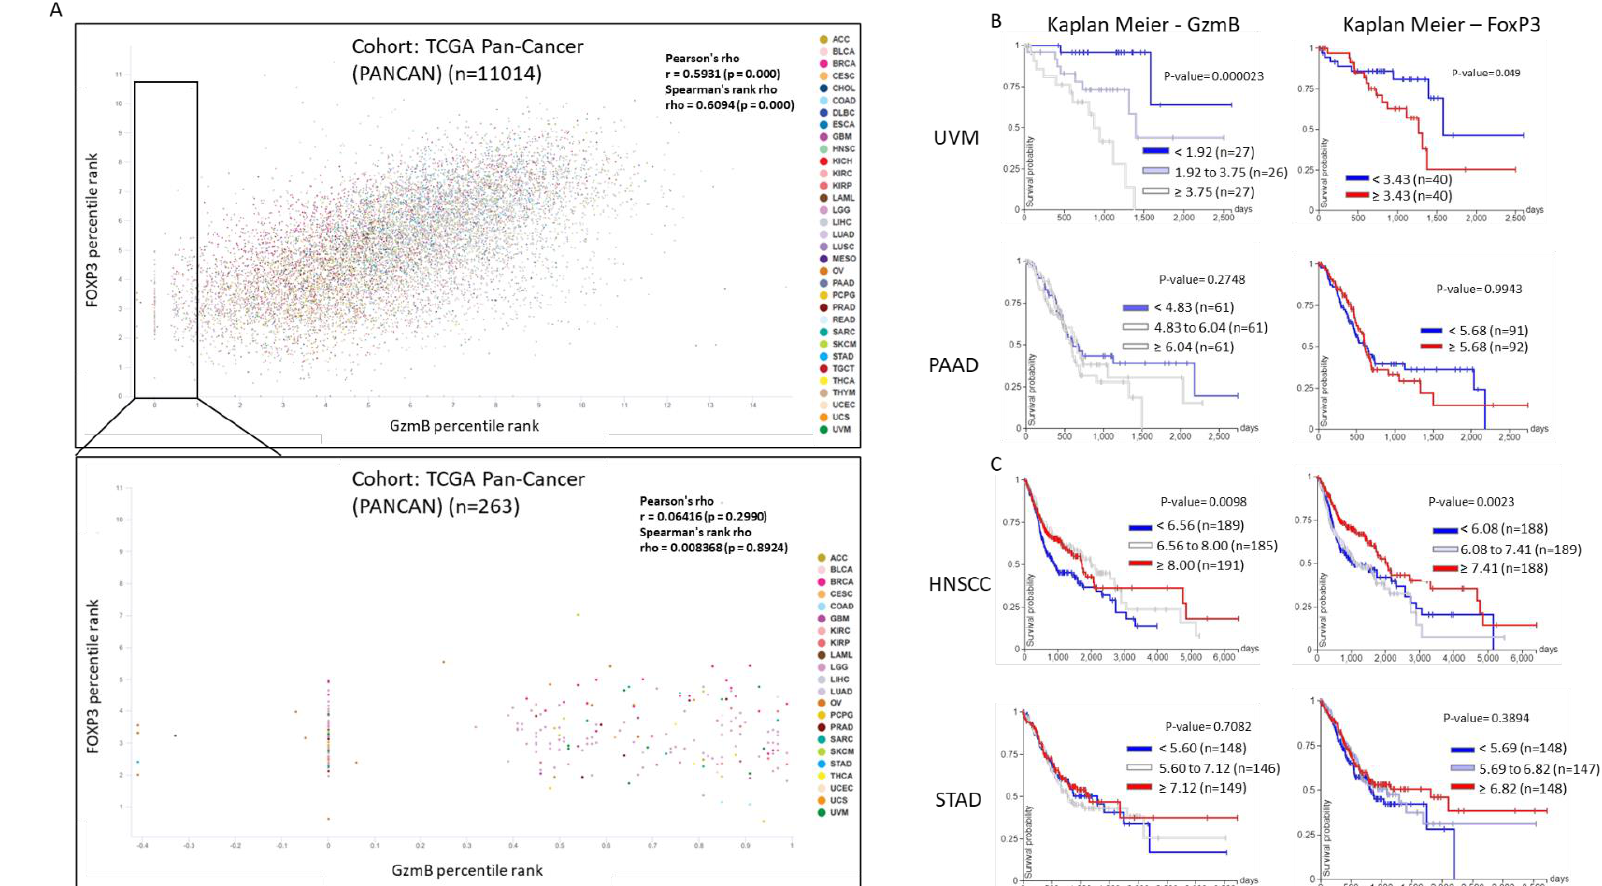
Figure 3. RNAseq analysis in the coexpression of GzmB and FoxP3. ( A ) Relationship between GzmB and FoxP3 expression in the TCGA Pan-Cancer database, identified by UCSC Xena. Color is denoted by cancer type. ( B ) Kaplan – Meier survival plot of GzmB and FoxP3 gene expression extrapolated from available RNAseq data from uveal melanoma or pancreatic adenocarcinoma patients demonstrating higher GzmB expression is associated with worse survival probability. ( C ) Kaplan – Meier survival plot of GzmB and FoxP3 gene expression extrapolated from available RNAseq data from head and neck squamous cell carcinoma or stomach adenocarcinoma patients demonstrating higher FoxP3 and GzmB expression is associated with better survival probability.